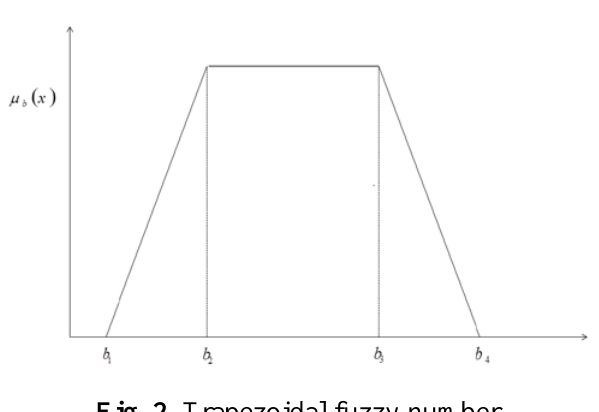
Fig. 2. Trapezoidal fuzzy